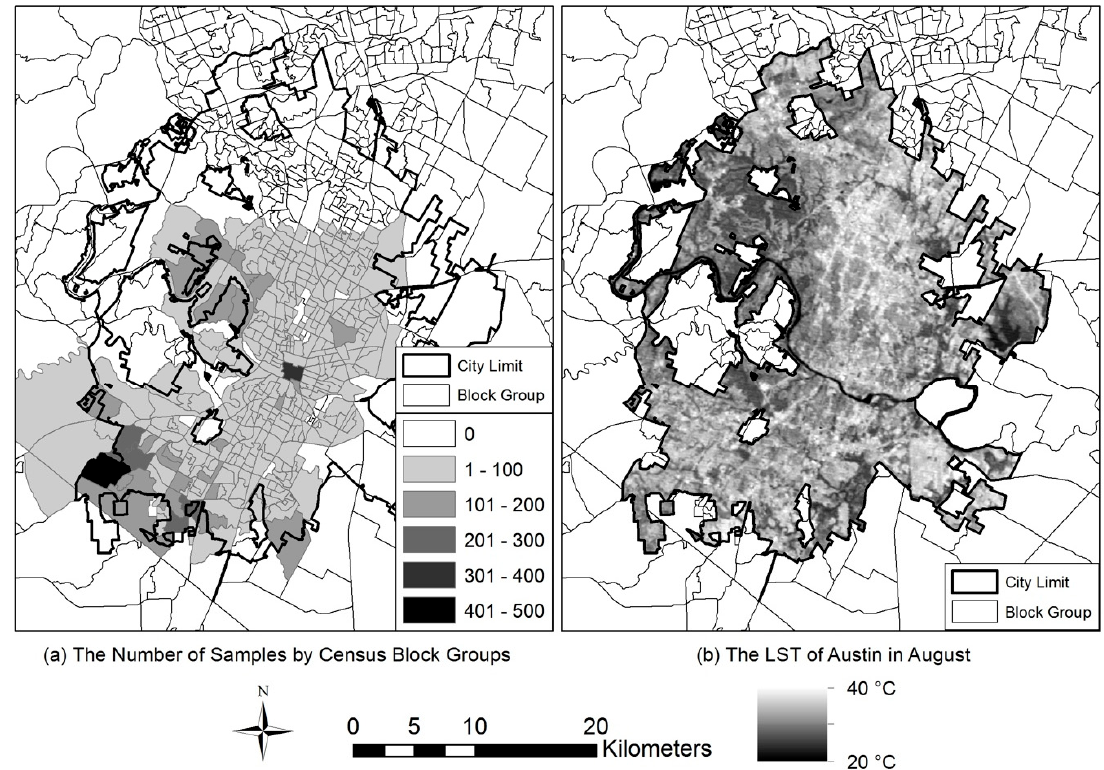
Figure 1. The distribution of the final study samples ( a ) and LST ( b ).